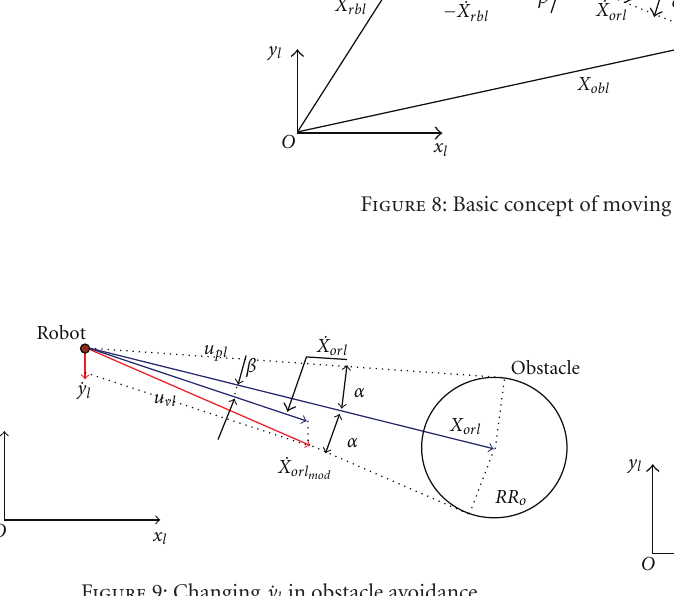
Figure 10: Worst-case collision